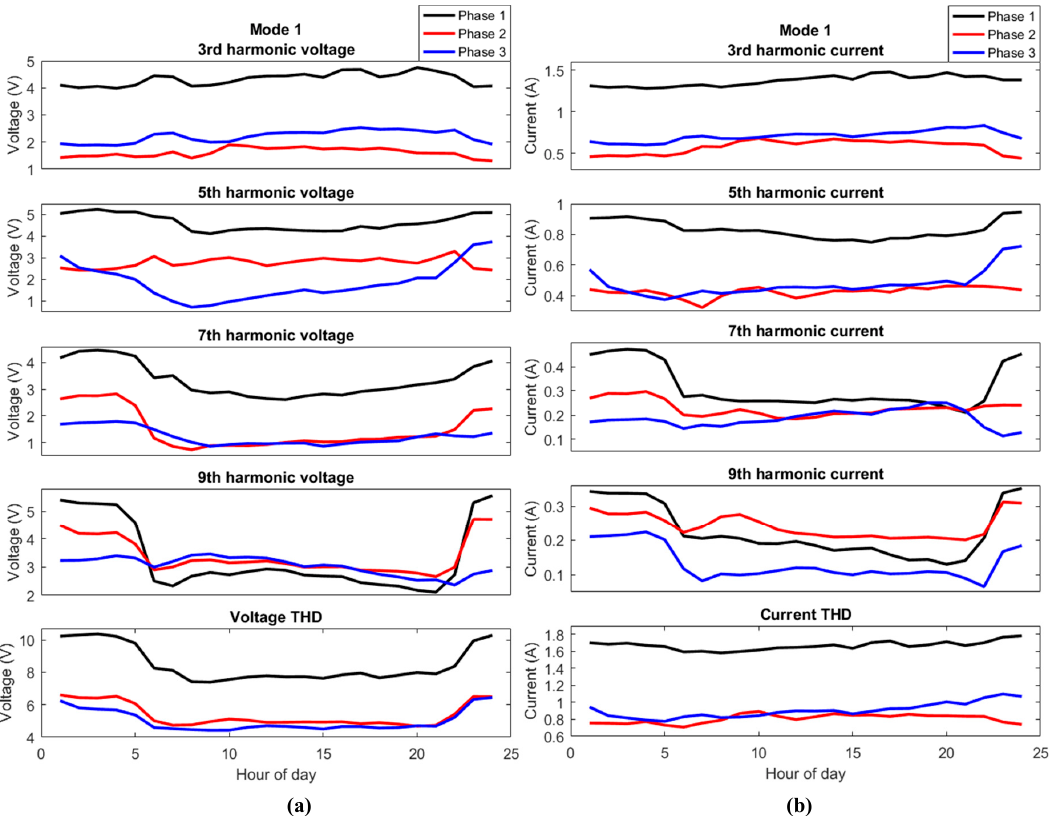
Figure 18. ( a ) The odd harmonic voltage 3rd to 9th and THD for mode 1 in Figures 14–16. ( b ) The odd harmonic current 3rd to 9th and THD for mode 1 in Figures 14–16. The average values are grouped for each hour of the day for around 8 weeks of islanded operation. Note also the difference in vertical scale for the different plots.